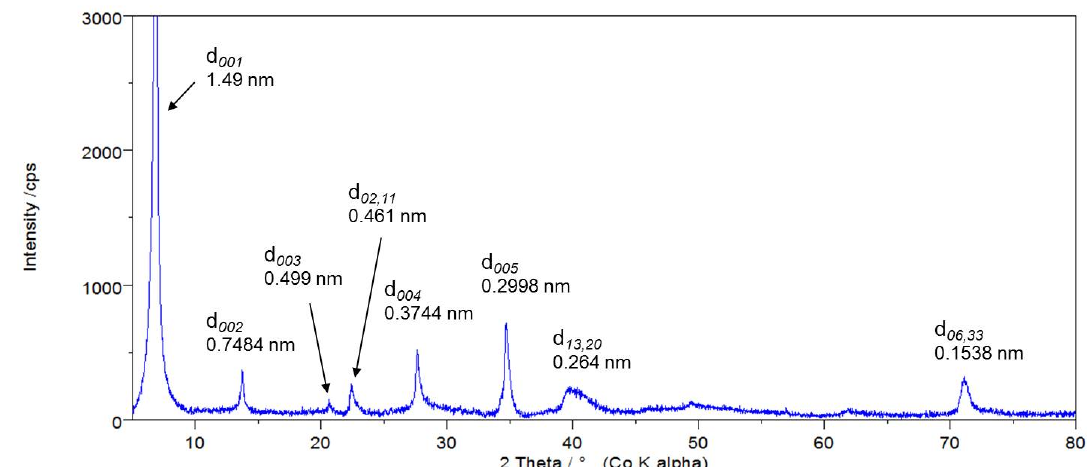
Figure 15. X-ray diffraction pattern of sample Jal Sm 01 (smeared powder, on Si low background holder, background corrected); indexing of the smectite phase: non-basal reflections are indexed two-dimensionally according to the turbostratic disorder of the smectite phase; the d 06,33 spacing of 0.1539 nm typically indicates a trioctahedral phase.